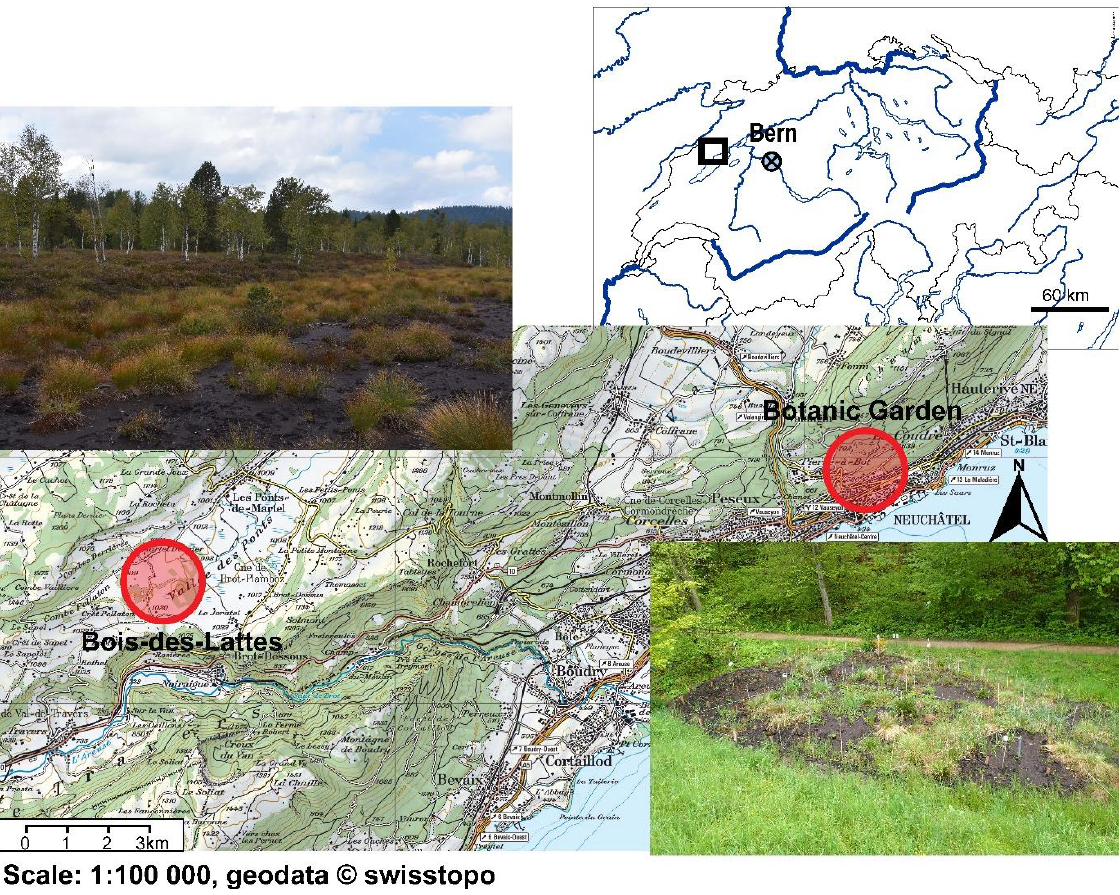
Figure 1. Locations and pictures of the experimental bog at the botanic garden in Neuchâtel and the Bois- des-Lattes peatland, Vallée des Ponts-de-Martel (Neuchâtel),